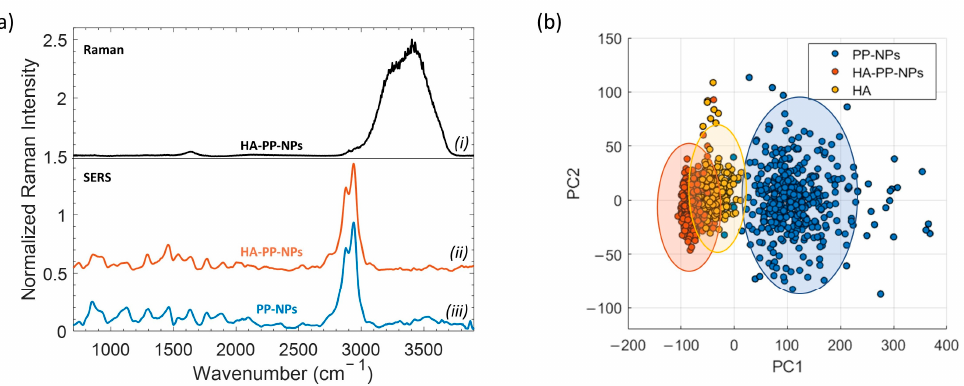
Figure 3. ( a ) Comparison of (i) Raman and SERS spectra of HA-PP-NP (ii) and PP-NP (iii) samples. The spectra were normalized and shifted; ( b ) score plot of PC1 versus PC2 for PP-NPs, HA-PP-NPs, and HA.